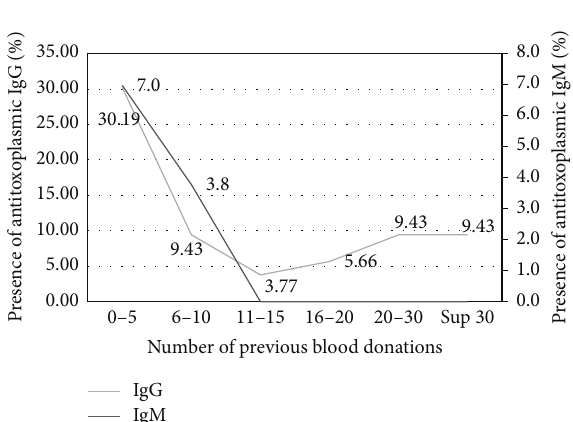
Figure 3: Frequency donor depending on the number of previous blooddonationsandthepresenceofIgMandIgG Toxoplasmagondii